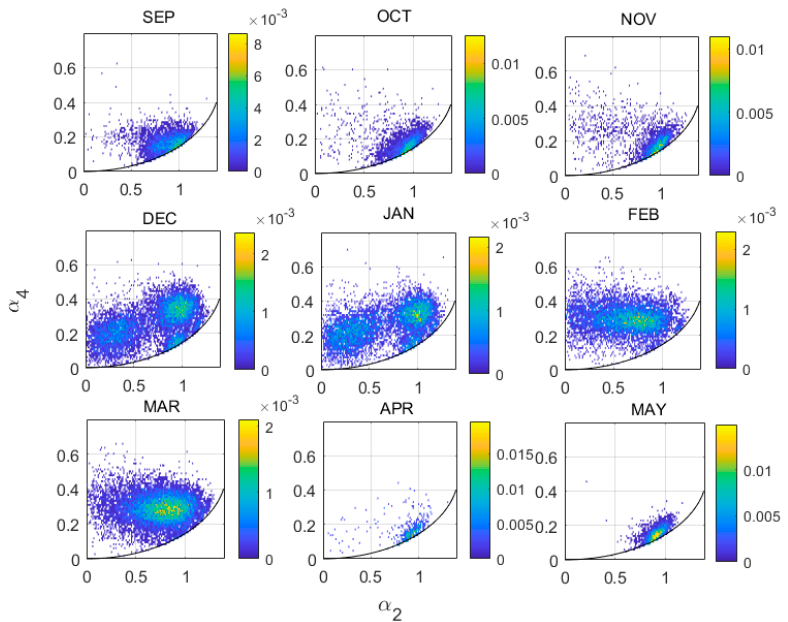
Figure 3. Distribution of the two shape parameters on the ( α 2 , α 4 ) plane for large insects ( a 0 range − 3 to 7 dBsc, f w range 21–50 Hz), for each month of the 2005–2006 flight season. Note that the horizontal scale is compressed compared to Figure 2. Other plot conventions as in Figure 2.